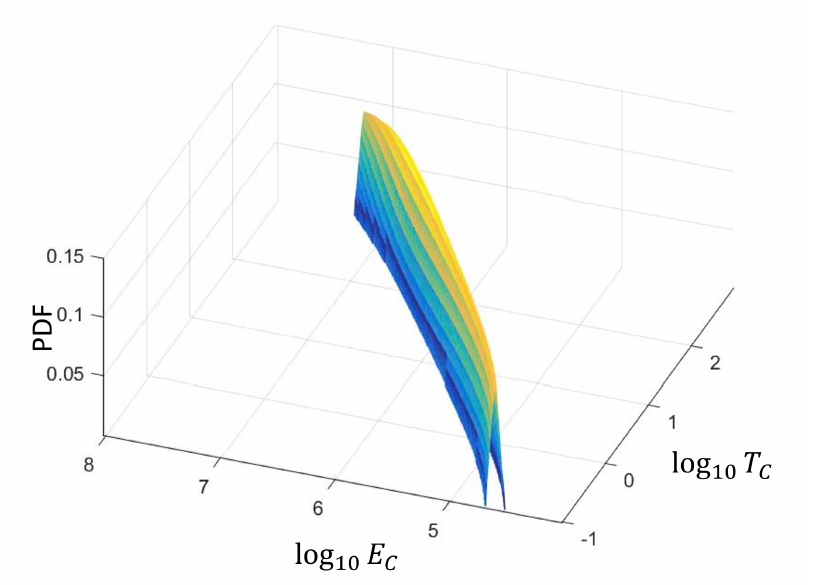
Figure 7. Fuse Melting probability distribution of EATON CLT-30A